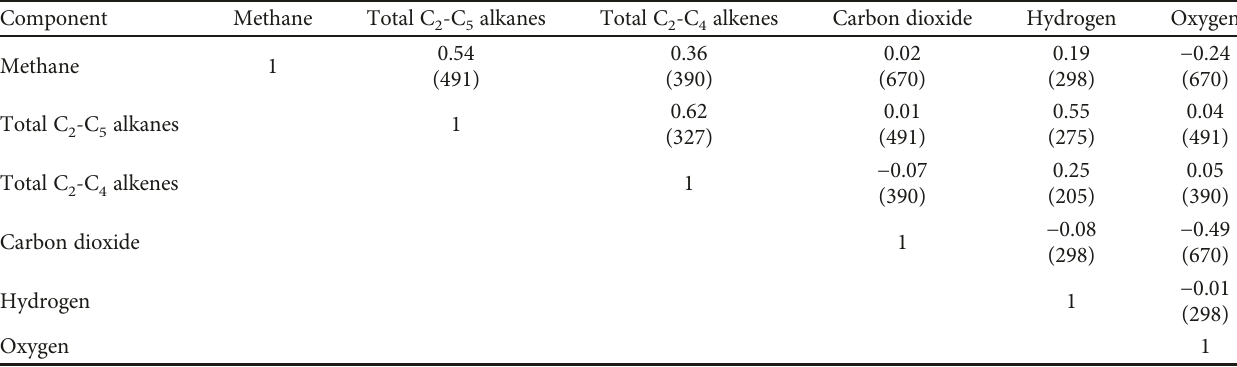
Table 6: Pearson correlation coe ffi cients of principal components analyzed in soil gas